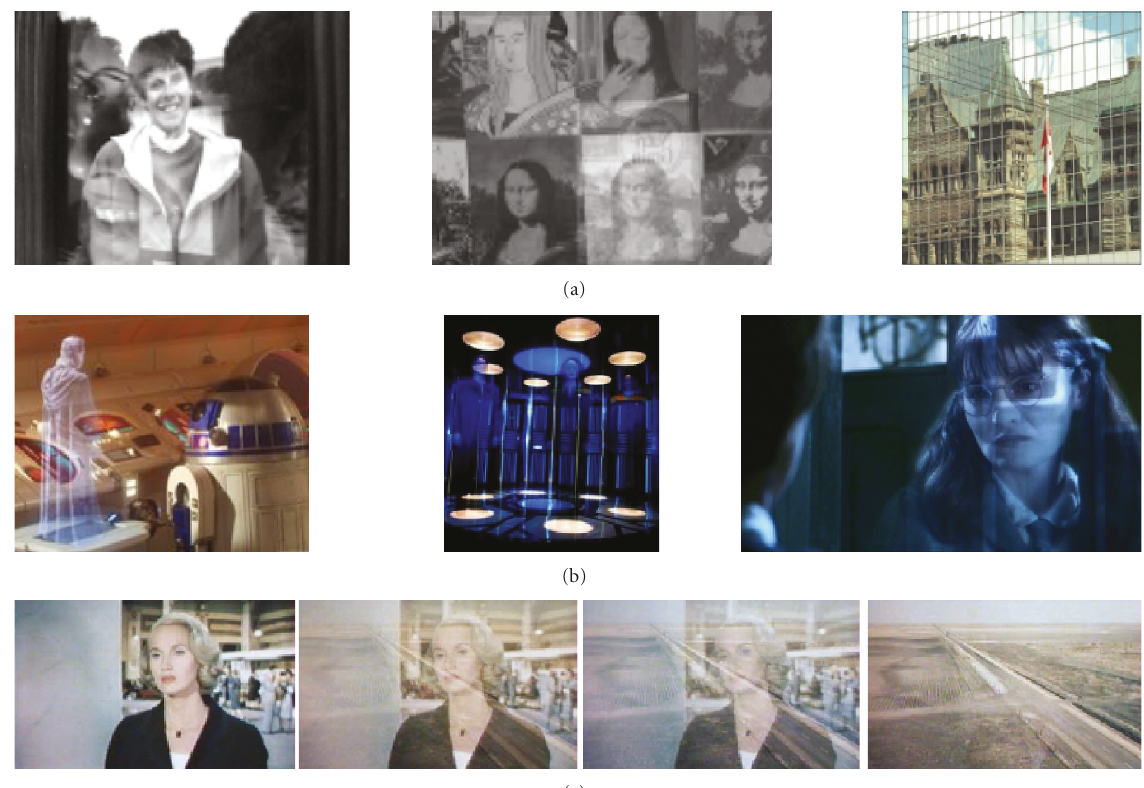
Figure 1: Examples of transparency configuration in videos. (a) Di ff erent reflections are shown, (b) three examples of phantom e ff ects, and (c) one example of a dissolve e ff ect for a gradual shot